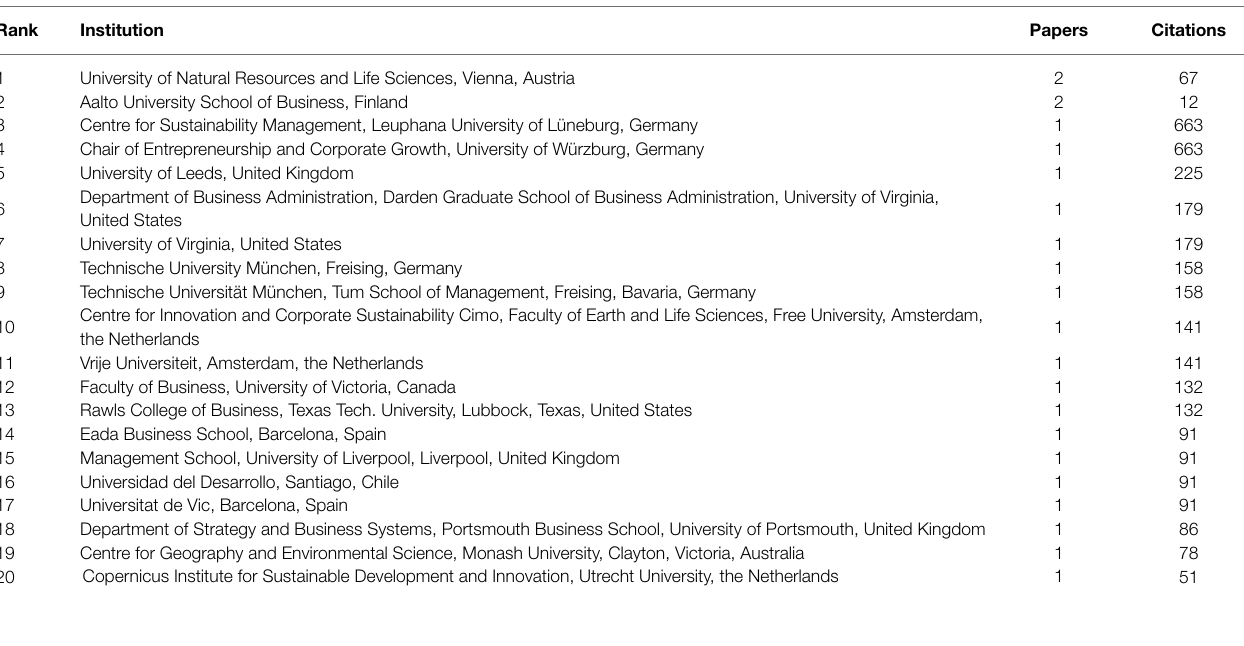
TABLE 4 | Institutional collaboration in neuroentrepreneurship